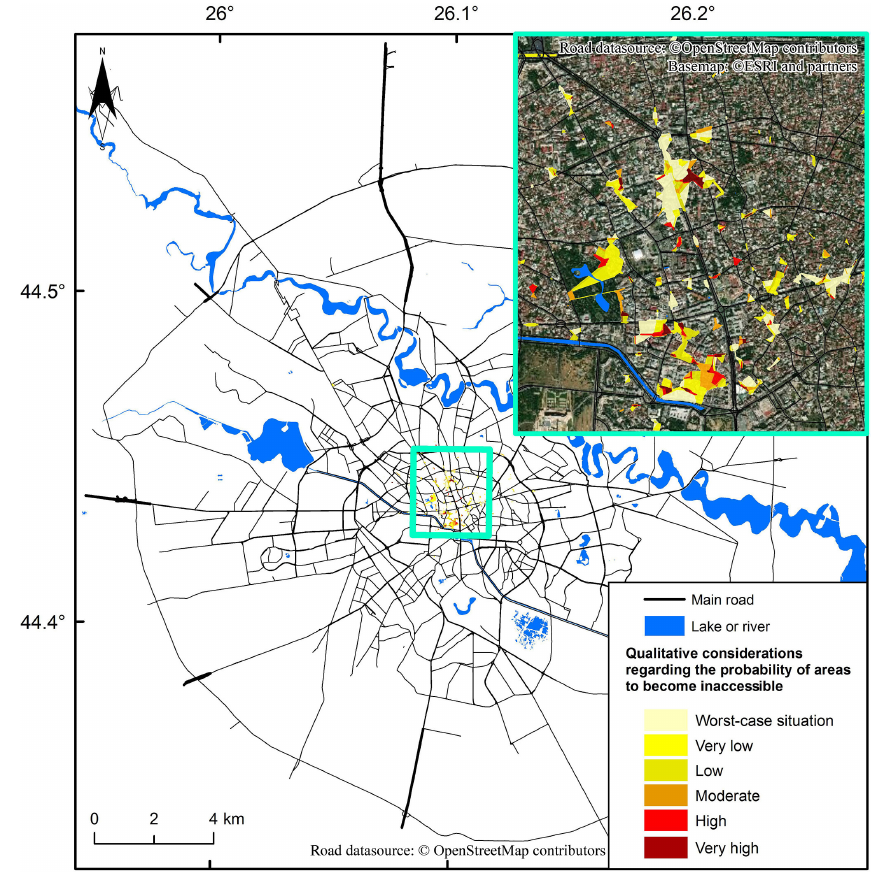
Figure 8. Areas that can become inaccessible immediately after an earthquake. (Datasource: © OpenStreetMap contributors 2019. Distributed under a Creative Commons BY-SA License; data from September 2016. Basemap: © ESRI and